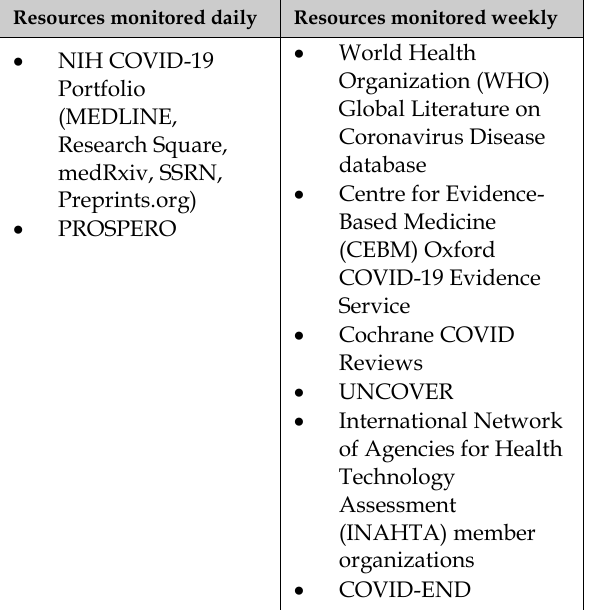
Figure 1 Icons used on the COVID-19 Evidence Reviews website to indicate additional information about